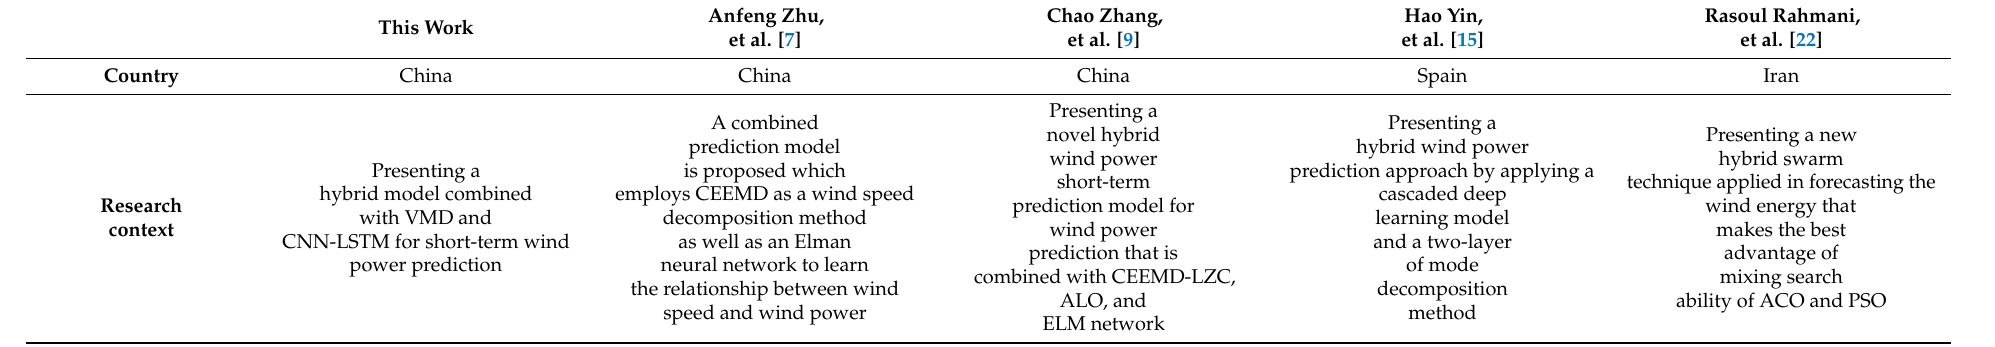
Table 2. Literature review of recent